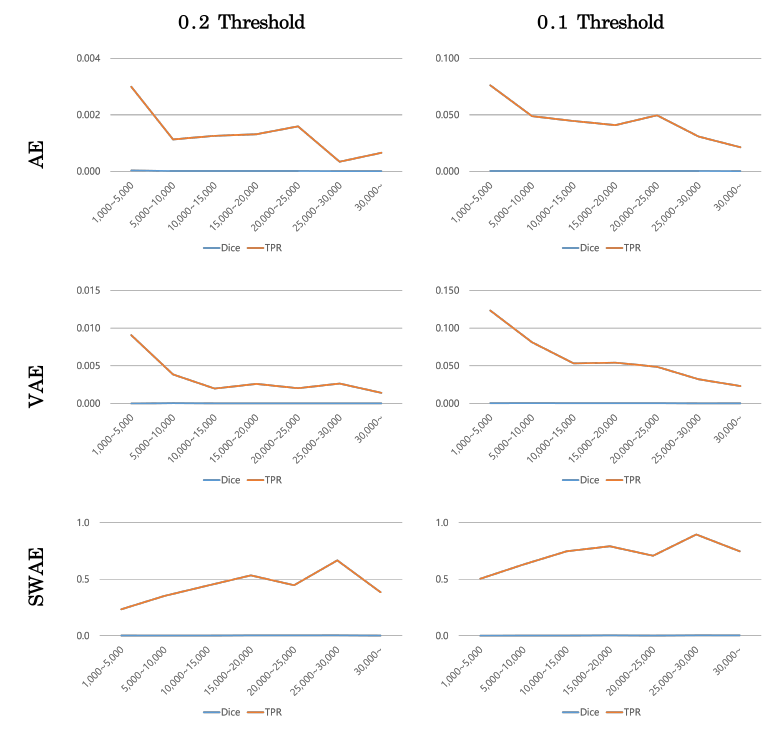
Figure 13. Changes in indicators according to tumor size by